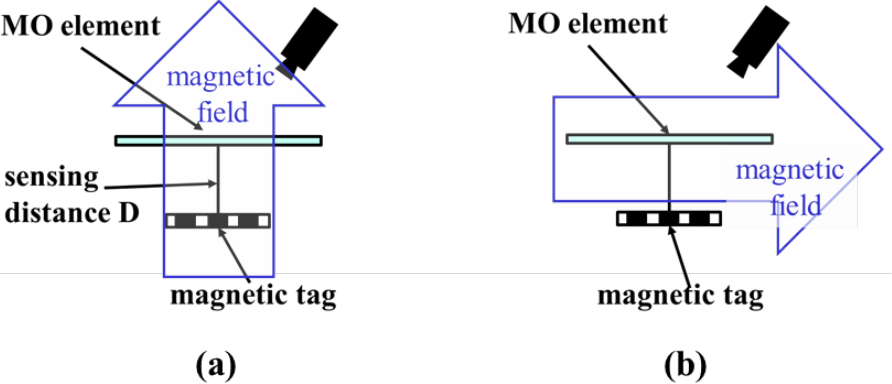
Figure 6. Two conditions of the magnetic field direction. ( a ) Magnets are placed opposite to the top and bottom of the o ff -plane magnetic field tag, and a magnetic field is applied perpendicular to the tag and the magneto-optical element. ( b ) Magnets are exposed opposite on the left and right of the in-plane magnetic field tag, and a magnetic field is applied in parallel with the tag and magneto-optical element. Ferrite magnets were exposed on both sides of the tag to apply a magnetic field, and tag imaging was performed (Figure 7). For the o ff -plane magnetic field, the external magnetic field itself is sensed. Hence, the magnetic substance cannot be strongly magnetized. The number of magnetic fluxes decreases and the image obtained changes as the magnetization direction changes. The in-plane magnetic field is better suited for tag recognition since the contrast of the tag information section is higher and more clearly recognizable for the in-plane magnetic field than for the o ff -plane one. Moreover, although the tag using gold is hardly recognizable due to the smaller magnetization amount, the tag using iron powder or nickel is recognizable due to the su ffi cient magnetization of the magnetic substance. From the viewpoint of biocompatibility, we decided to use a tag containing iron powder since a living organism may react negatively to nickel. Also, this tag can be stably identified half a year after being produced, so they are stable for a long